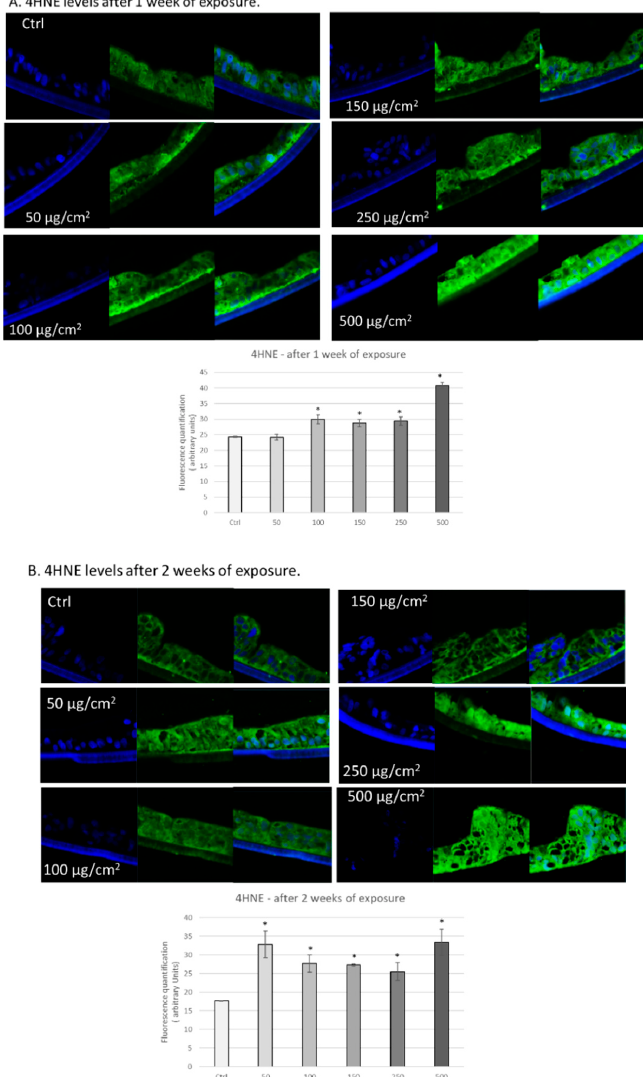
Figure 2. Exposure to particulate matter increased levels of 4HNE after 1 week and 2 weeks of exposure. Representative immunofluorescence images of levels of 4HNE (green color) in human 3D intestinal tissues after 1 week (A) or 2 weeks (B) of exposure with the following doses of PM: 50, 100, 150, 250, and 500 µg/cm 2 . Green staining represents 4HNE. Blue staining represents DAPI. Quantification of at least 3 independent images taken of stained tissues from two independent experiments is represented in graphs A and B. Data are expressed as arbitrary units (averages ± SEM of two experiments, * p < 0.05).